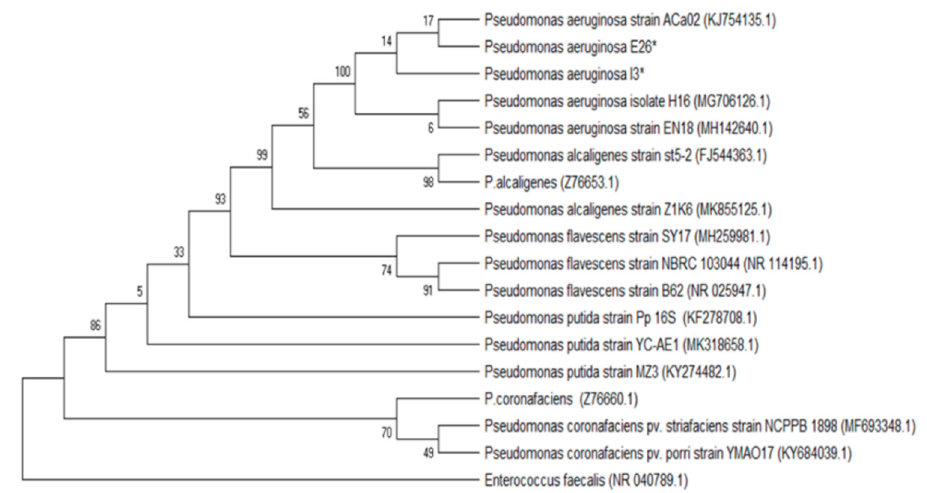
Figure 6. Phylogenetic tree based on the 16 S rRNA gene sequences of the Pseudomonas aeruginosa isolates and reference sequences. The analysis included 18 sequences selected from GenBank, and the access number is given in parenthesis. An asterisk identifies the bacterial isolates from this study.